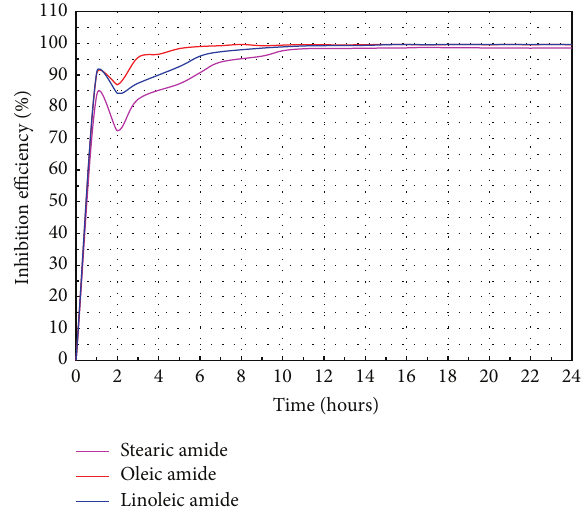
Figure 5: Variations of inhibition efficiency as determined by LPR